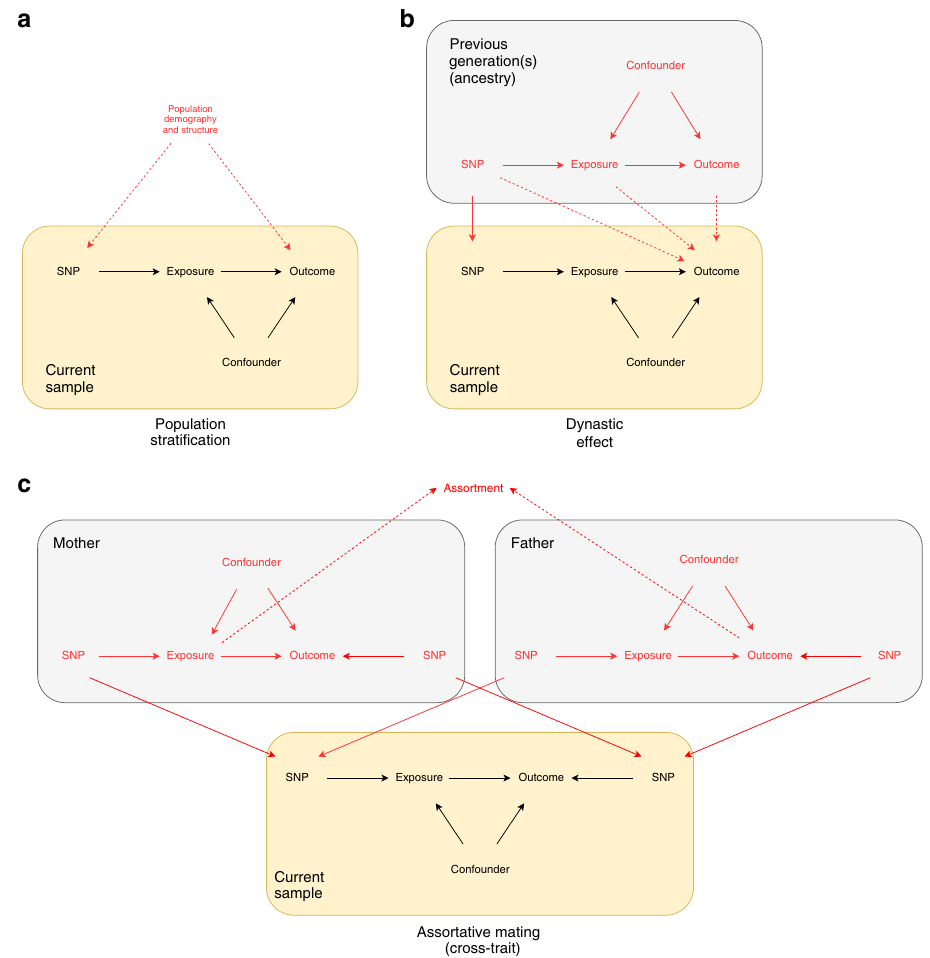
Fig. 1 Directed acyclic graphs illustrating how population structure and familial effects can cause confound MR studies. Black arrows indicate causal paths in the index individual, red arrows indicate causal paths in the parents, and dashed red arrows indicate confounding paths. The MR estimate of the causal effect of the exposure on the outcome is biased because of potentially unobserved confounders between the SNPs and the exposure and the outcome. a Illustrates how population demography and structure can confound the SNP-outcome association. b Illustrates how dynastic effects can induce the same statistical confounding structure of the SNP-outcome association through an entirely different mechanism. The solid red vertical arrow indicates the genetic inheritance of germline DNA. The dotted line indicates the direct (dynastic) effect of the parents on the offspring ’ s outcomes. These can either be mediated via the exposure, the outcome or some other mechanism indicated by the direct arrow from SNP to offspring outcome. MR estimates of the effect of the exposure on the outcome in samples of unrelated individuals will be biased because there is a path between offspring SNP and the outcome via the effect of the parents ’ phenotypes on their offspring ’ s outcomes (dynastic effects). The presence of dynastic effects would violate one of three key MR (instrumental variable) assumptions — the independence assumption. Estimates that control for mother or father genotype, or sibling genotype will close this path and be unbiased. c Illustrates how assortative mating is a third mechanism that can confound the SNP-outcome association. In this example we present cross-trait assortative mating where there is a pathway between the mother ’ s genotype and offspring ’ s outcome via the father ’ s genotype for the outcome. All these forms of SNP-trait confounding can be accounted for by using methods based on within-family